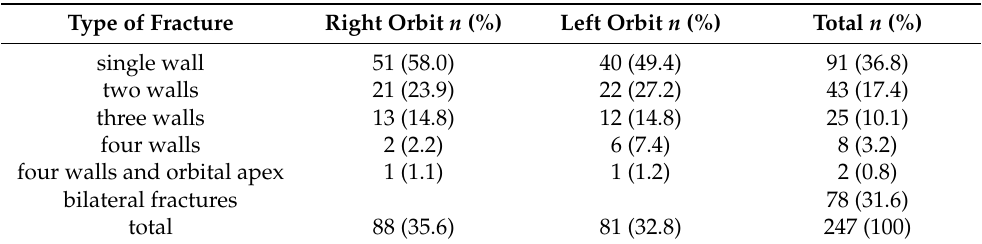
Table 3. The distribution of fractures showed no significant difference between the left and right orbit. Type of Fracture Right Orbit n